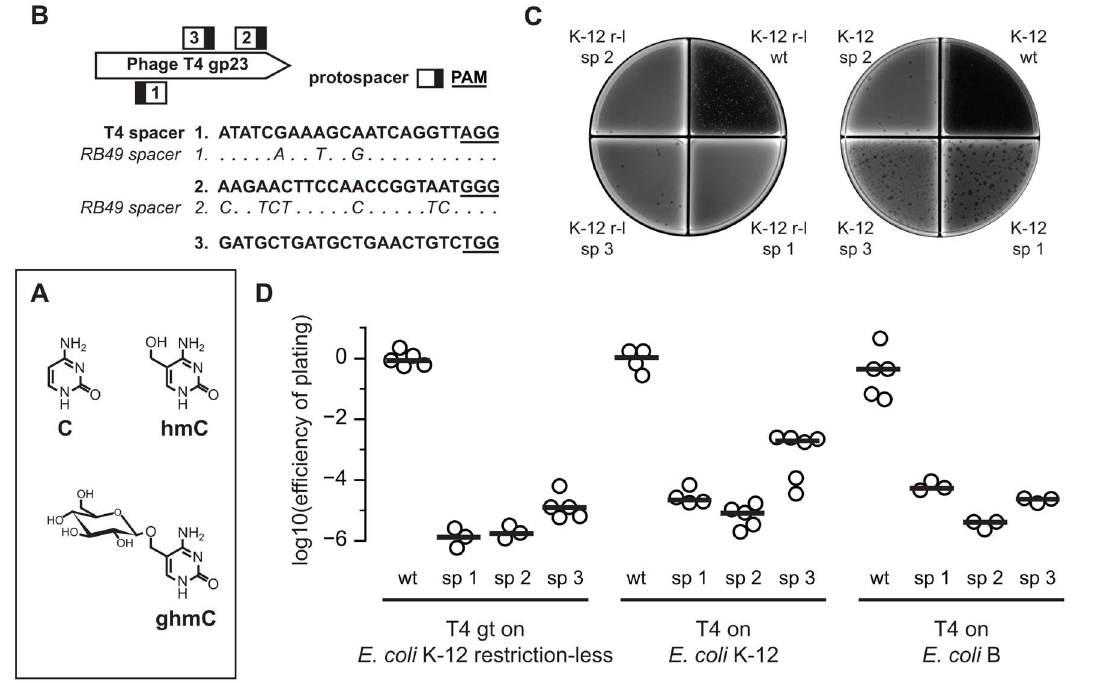
Figure 4. Cas9 reduces E.coli susceptibility to phages T4 and T4 gt. (A) The structures of cytosine and modified cytosines are shown. T4 gt has 100% hydroxymethylated cytosines (hmCs). T4 has 100% glucosyl-hydroxymethylated cytosines (ghmCs), specifically 70% a - and 30% b -ghmCs. The ghmC structure shown is in the b -configuration. (B) Spacers against T4 were also designed against the major capsid protein (gp23), which is homologous to that of RB49. For comparison, the RB49 protospacers are aligned below in italics, where dots indicate identical nucleotides. In the T4 sequences, the PAM is underlined. The PAM (black box) and protospacer (white box) are represented on the gene. (C) In a typical plaque assay with T4 gt (left plate), there was complete lysis on wild-type (wt) restriction-less (r-l) E. coli K-12 and few plaques on cells with spacers 1, 2, or 3 (sp 1, sp 2, or sp 3). In an assay with T4 (right plate), there was complete lysis on wild-type E. coli K-12 MG1655, numerous plaques on cells with spacer 1 or 3, and about a dozen on spacer 2. (D) The efficiency of plating of T4 and T4 gt was quantified for each protected strain relative to the unprotected wild-type strain. Independent replicates of restriction-less E. coli K-12 (n=5, 3, 3, 5), E. coli K-12 (n=4, 4, 5, 6), and E. coli B (n=5, 3, 3, 3) are plotted. Lines represent the